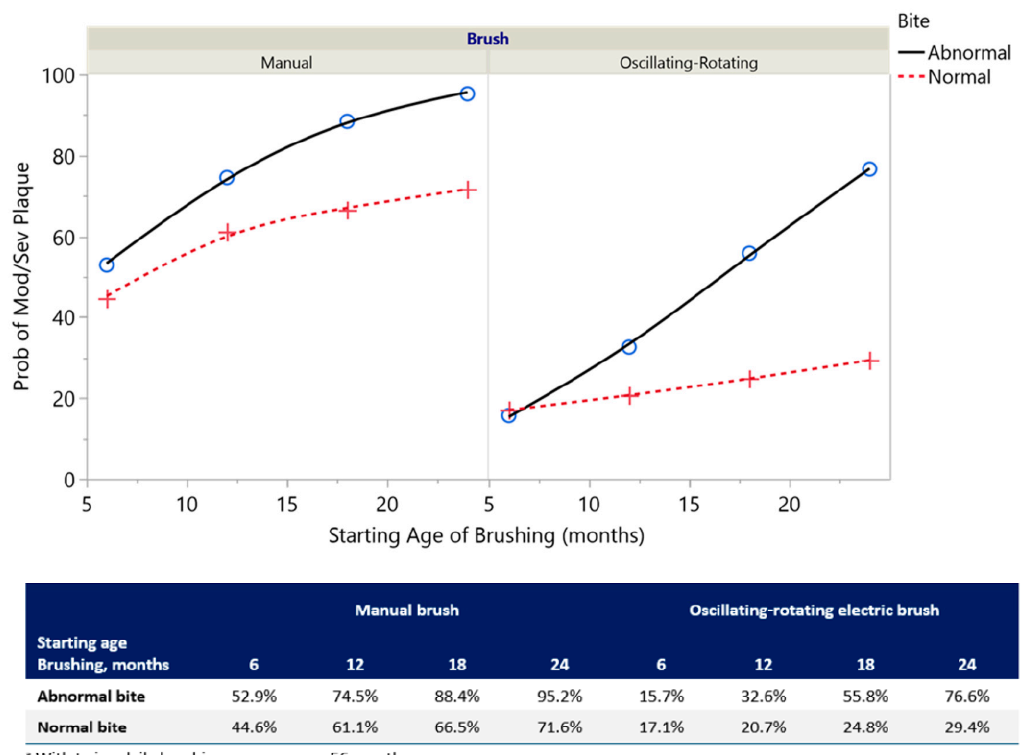
Figure 2. Probability a of moderate / severe plaque by Brush Type, Bite Type, and Starting Age of Brushing (months) from the model in Table